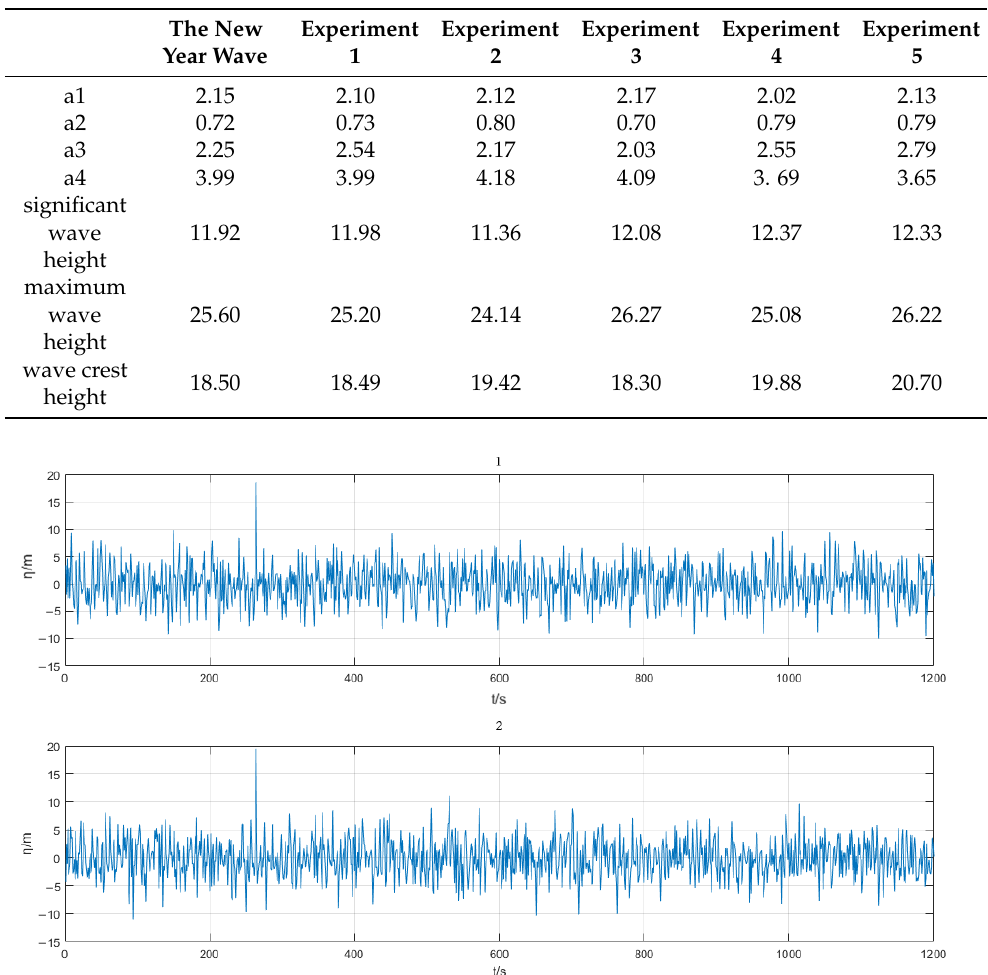
Figure 5. Numerical simulation of “ The New Year Wave ” wave train 1 and wave train 2. Table 4. Comparison of parameters between the measured “ New Year Wave ” and the numerical simulation “ New Year Wave ” .